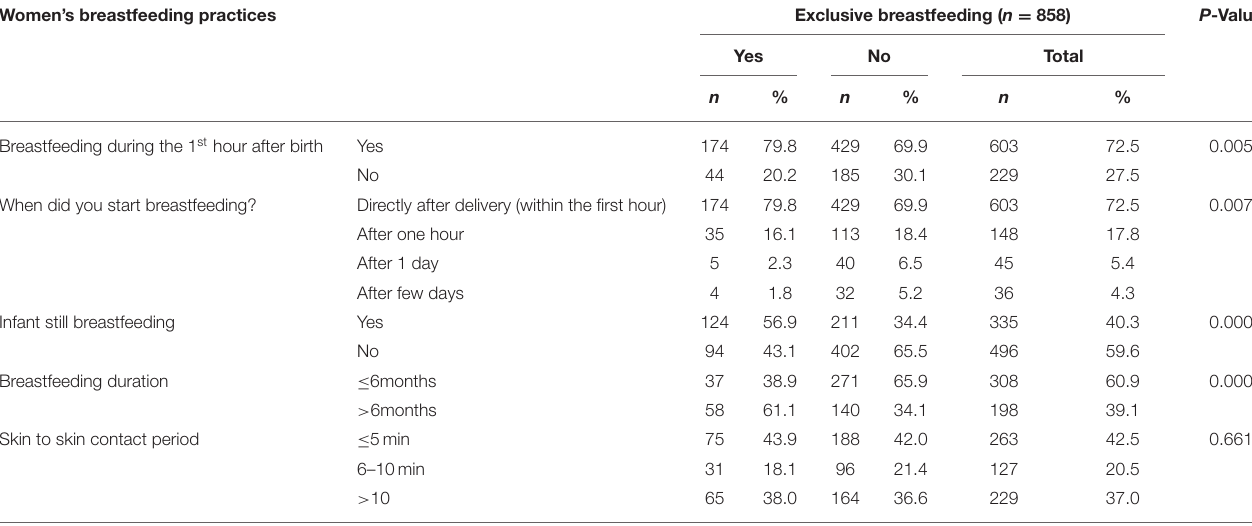
TABLE 6 | Association between EBF and different feeding practices. Women’s breastfeeding